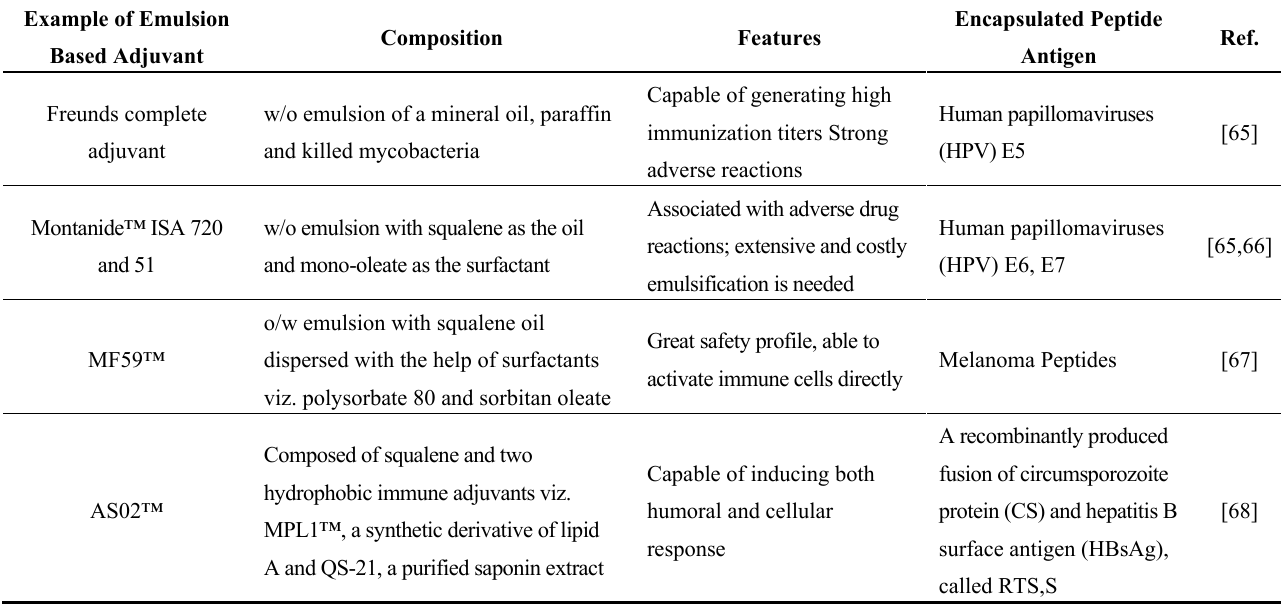
Table 2. Currently marketed emulsion based delivery